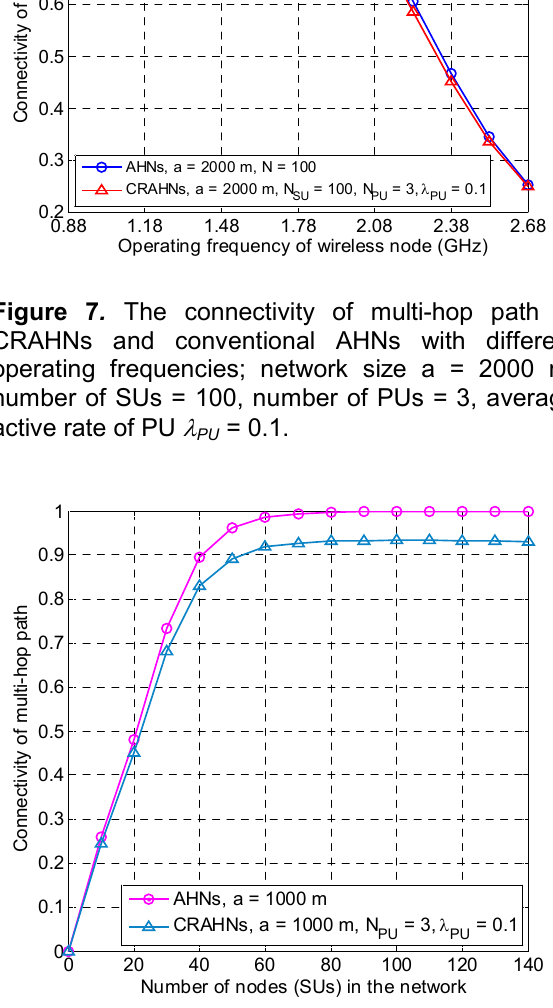
Figure 8 . The connectivity of CRAHNs compared with conventional AHNs with different numbers of wireless nodes (SUs); the number of PUs = 3, = 0.1, one frequency average active rate of PU l PU layer with operating frequency f = 2.4